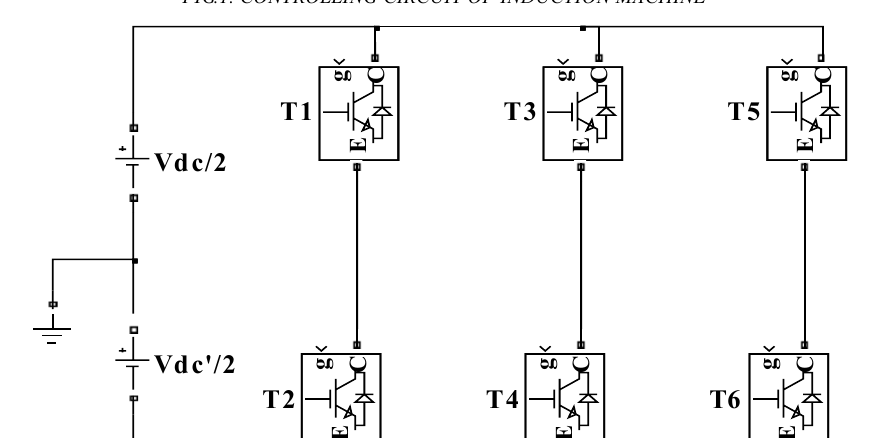
FIG.1. CONTROLLING CIRCUIT OF INDUCTION MACHINE